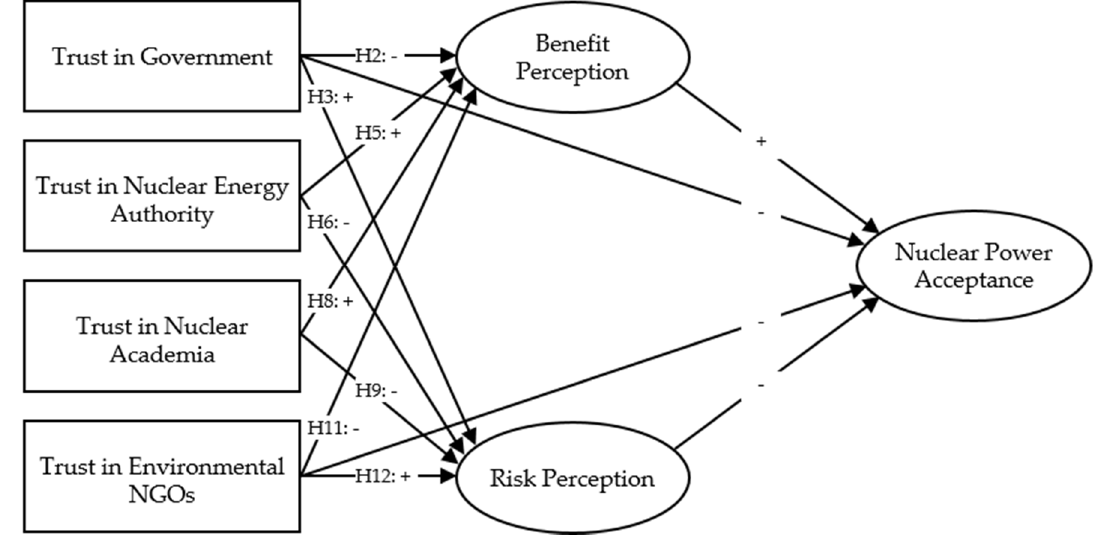
Figure 2. The final model. The variable in a rectangle was measured by a single item; the one in an ellipse is a multiple-item variable. Covariances between the trust variables are not explicitly shown in this figure for readability. + : a positive effect; − : a negative effect.